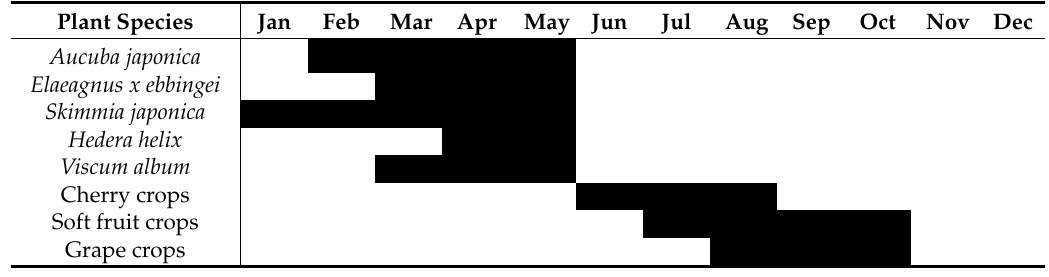
Table 1. Fruit seasonality of early spring hosts of D. suzukii and commercial crops in the study